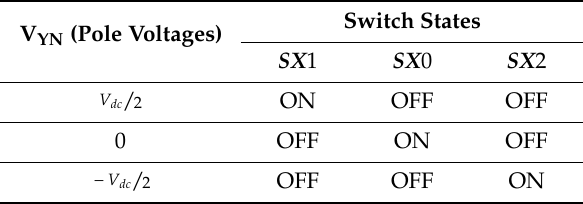
Table 1. Transistor clamped three-level inverter voltage level and switching states Switch States (Pole Voltages) 𝐕 𝐘𝐍 𝑺𝑿𝟏 𝑺𝑿𝟎 𝑺𝑿𝟐